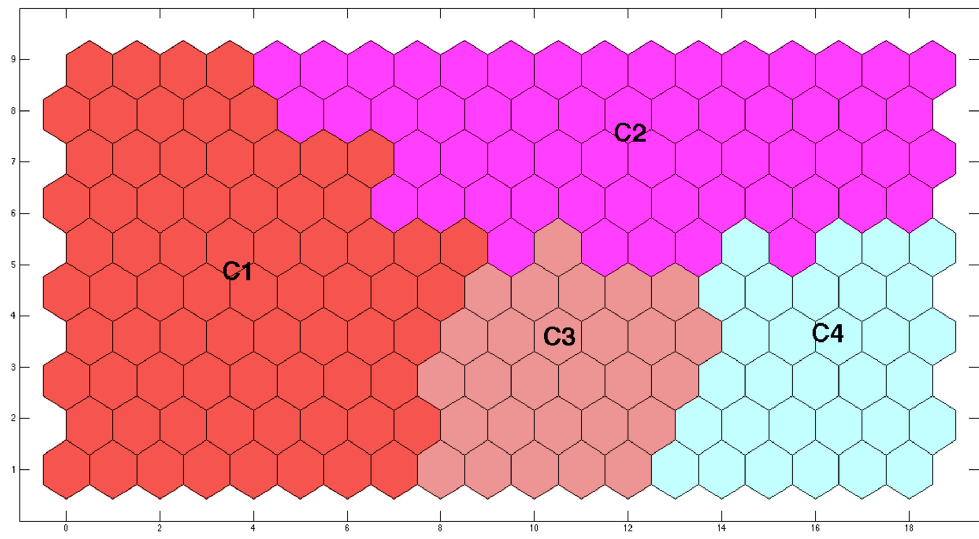
Figure 7. Clustering obtained after applying the K-means algorithm to the map provided by the SOM. Table 2. Values of the 16 parameters associated with each one of the centroids defining the four clusters obtained with the K-means algorithm. The three selected as more representative of the system dynamics are highlighted.